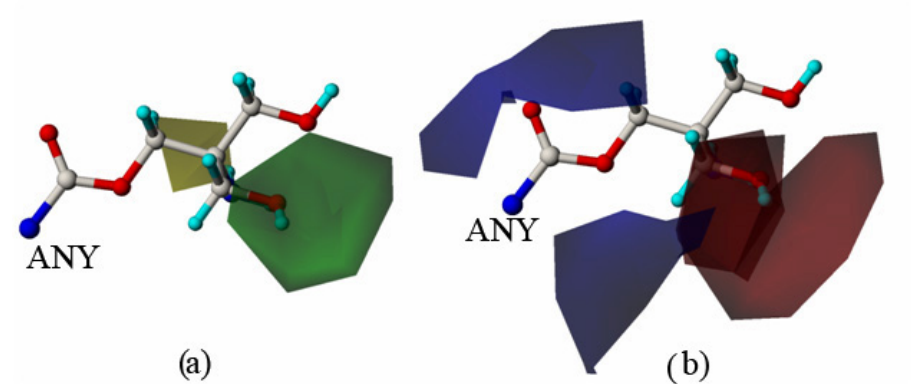
Figure 4. Topomer CoMFA contour maps around R1. ( a ) Steric contour map depicted around R1 (green: favored; yellow disfavored); ( b ) electrostatic contour map depicted around R1. Blue contours indicate the regions where electropositive groups increase activity, whereas red contours indicate the regions where electronegative groups increase activity.